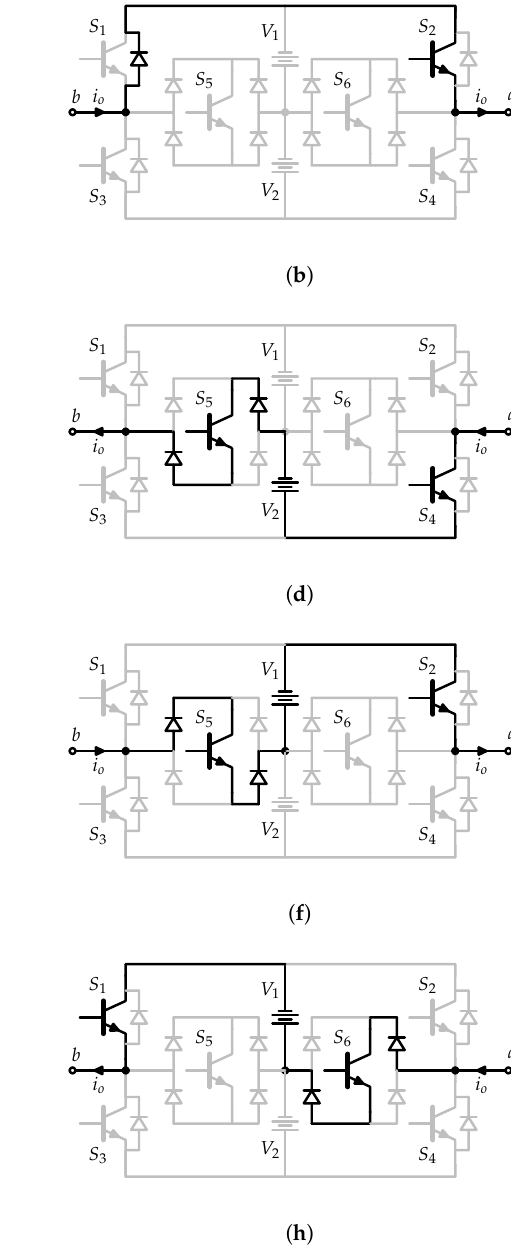
Figure 4. Schematics of switching states for generating different levels in the output voltages (see Table 1): ( a ) state 1 for V ab = 0; S 3 = S 4 = 1, ( b ) state 9 for V ab = 0; S 1 = S 2 = 1, ( c ) state 2 for V ab = + V 2 ; S 3 = S 6 = 1, ( d ) state 3 for V ab = − V 2 ; S 4 = S 5 = 1, ( e ) state 5 for V ab = +( V 1 + V 2 ) ; S 2 = S 3 = 1, ( f ) state 6 for V ab = + V 1 V ; S 2 = S 5 = 1, ( g ) state 7 for V ab = − ( V 1 + V 2 ) ; S 1 = S 4 = 1, and ( h ) state 8 for V ab = − V 1 ; S 1 = S 6 =